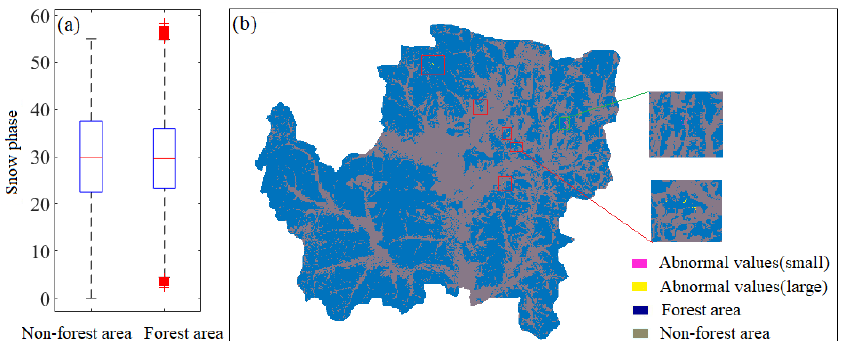
Figure 9. Snow phase analysis before correction: ( a ) snow phase box-plot diagram, there is no abnormal value in non-forest areas, while a snow phase in forest areas larger than 54.8 is recognized as a large abnormal value, and less than 4.38 as a small abnormal value; ( b ) distribution of abnormal values of snow phase in forest area, the red boxes show the location of large abnormal values, and the green box is small abnormal values.